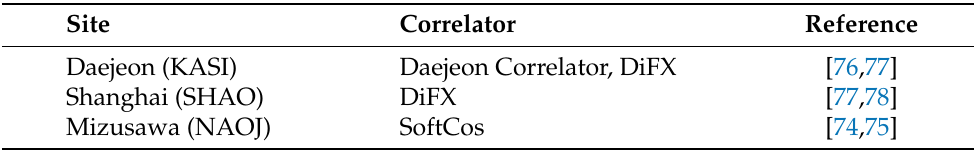
Table 3. Correlators used for EAVN observations.